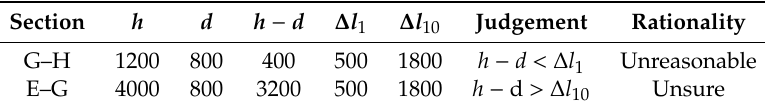
Table 3. Judgement on the different sections (G–H and E–G).